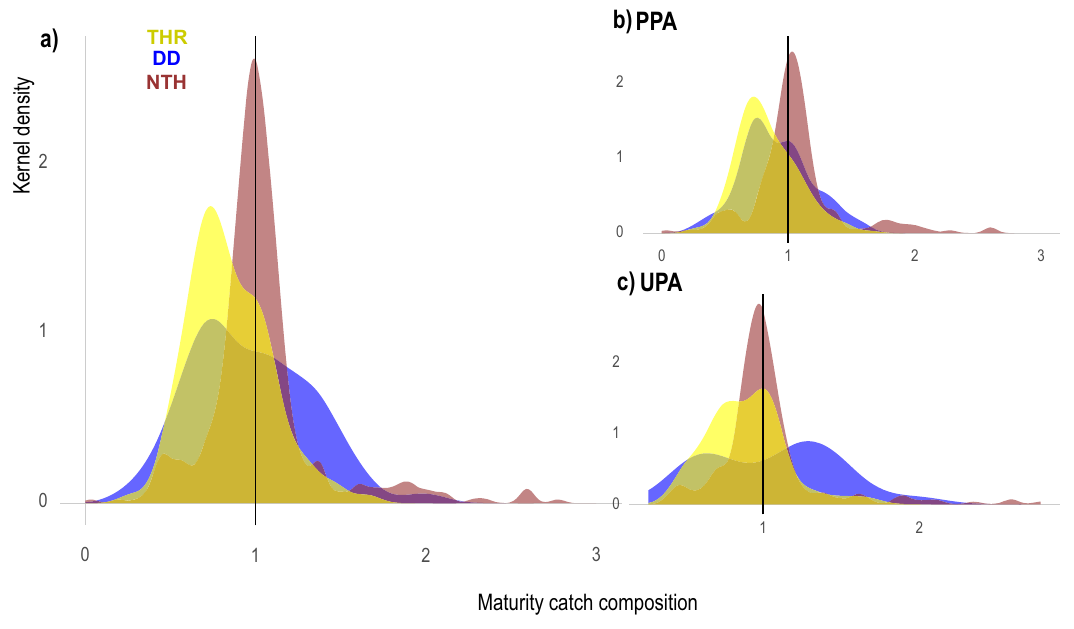
Fig.3|Kerneldistributionplots.a Proportionsofmature (standardizedmaturity index ≥ 1) and immature (standardized maturity index <1) specimens caught (data fromPPAsandUPAspooled)forthethreeextinctionriskgroups(TH=Threatened,